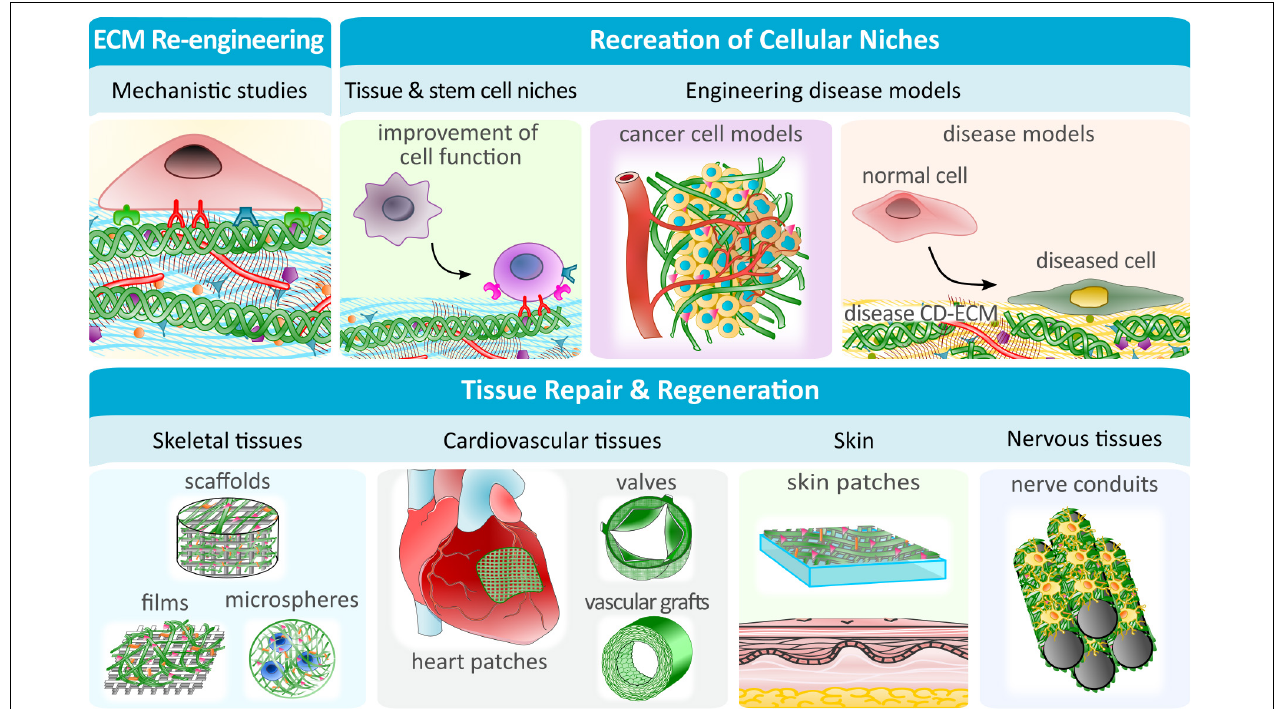
FIGURE 2 | CD-ECM applications in fundamental research, pathophysiological studies and renegerative medicine. The ease with which CD-ECM can be modified, makes it the ideal platform to study detailed ECM mechanisms or the role of cellular niches under physiological and pathophysiological conditions. Specialized engineered cellular niches can be further utilized to improve cellular functions in vitro , such as stemness. In TERM, CD-ECMs can be created with specific mechanical and biological properties to be used on their own (i.e., as vascular grafts) or to enhance the performance of (semi-) synthetic